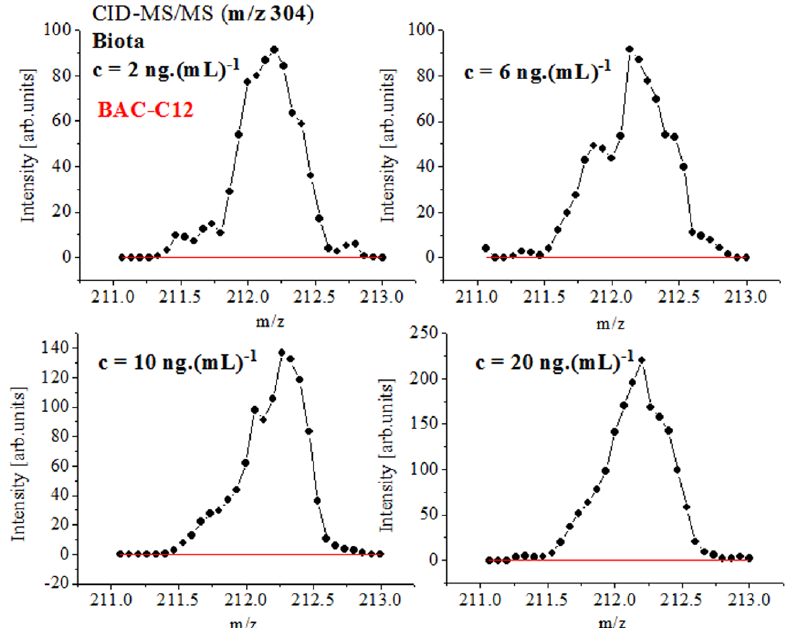
Figure 4. SRM spectra of analyte BAC-C12 in biota, using analyte molecular cation [M] + at m / z 304 at Figure 4 . SRM spectra of analyte BAC - C12 in biota, using analyte molecular cation [M] + at m / z 304 concentrations c = 2, 6, 10, and 20 ng.(mL) –1 ; baseline correction of isotopologies; data on trapezoidal at concentrations c = 2, 6, 10, and 20 ng.(mL) – 1 ; baseline correction of isotopologies; data on integration approach (see also Figures trapezoidal integration approach (see also Figures S 22 –S 24) .